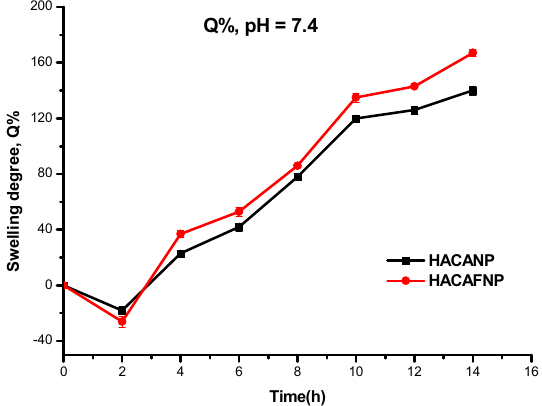
Figure 5. Time variation of the swelling degree for the chitosan nanoparticles in PBS at a pH of 7.4.